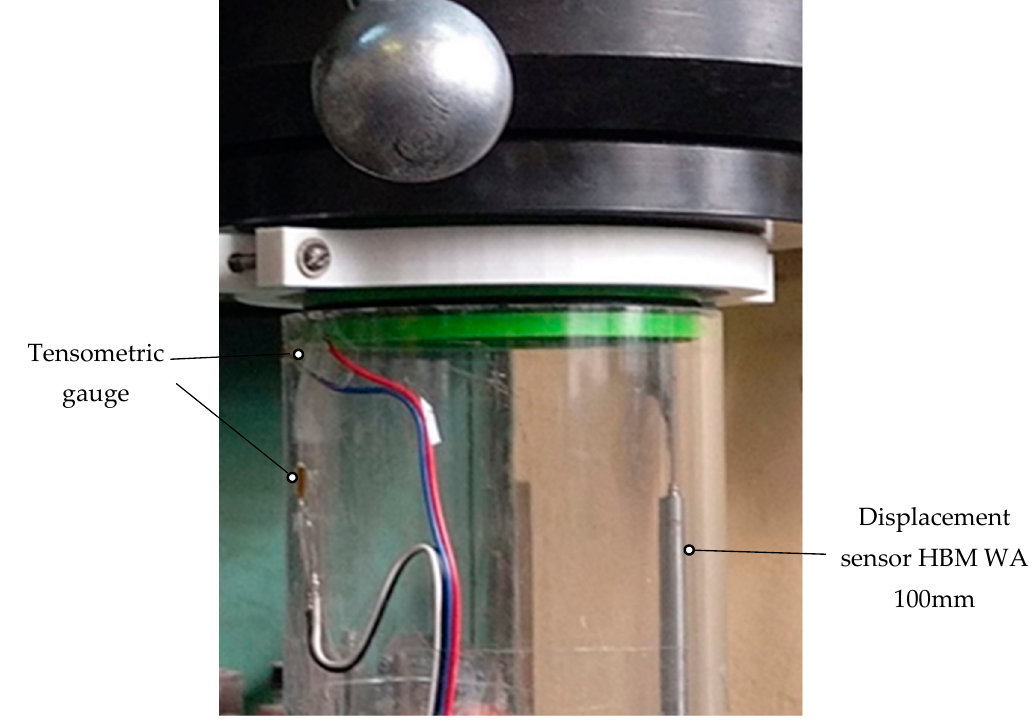
Figure 8. Cylinder detail in the area of tensometric marks.